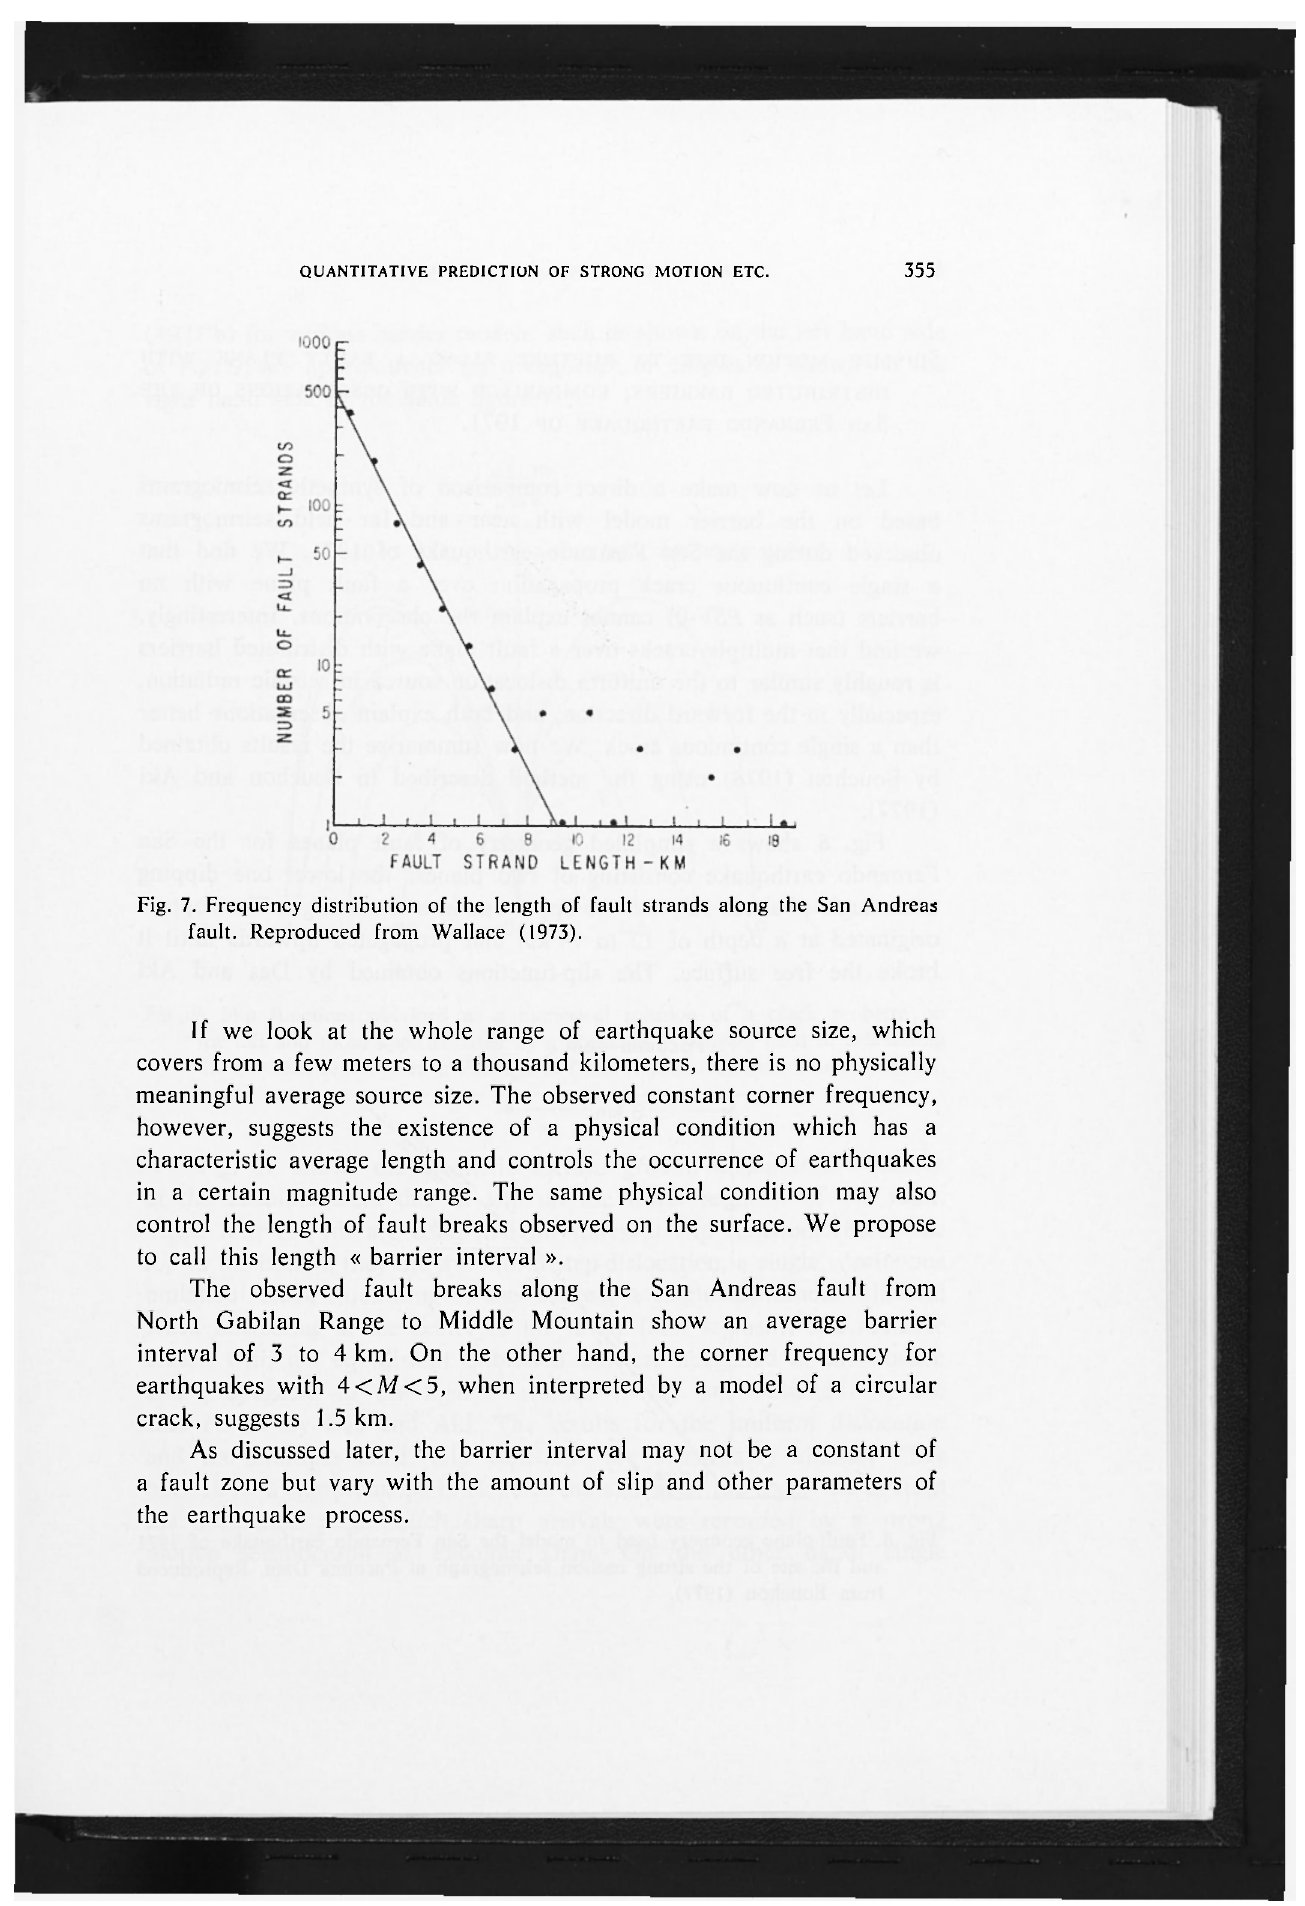
Fig. 7. Frequency distribution of the length of fault strands along the San Andreas fault. Reproduced from Wallace